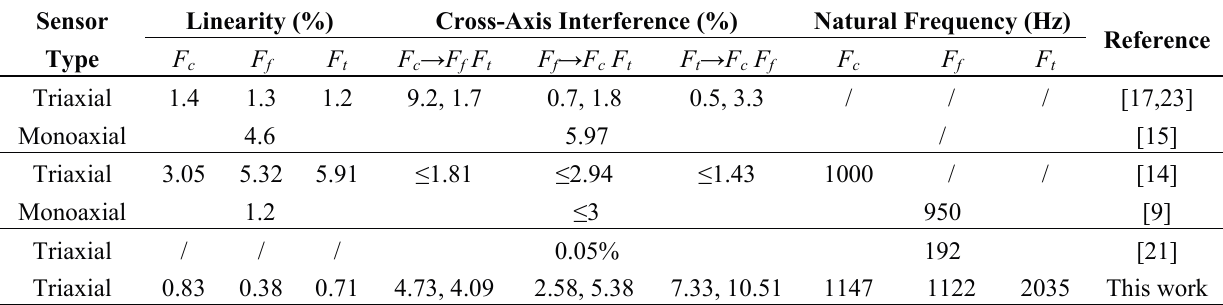
Table 4. Comparison between the current state-of-the-art sensors and the sensor in this